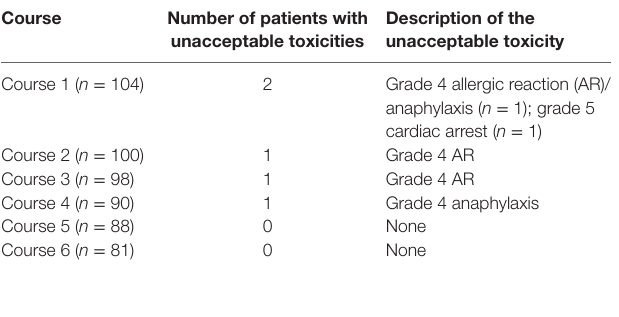
TaBlE 2 | Toxicities defined as “Unacceptable” according to COG protocol ANBL0931 ( n = 105 patients enrolled). Course number of patients with Description of the unacceptable toxicities unacceptable toxicity